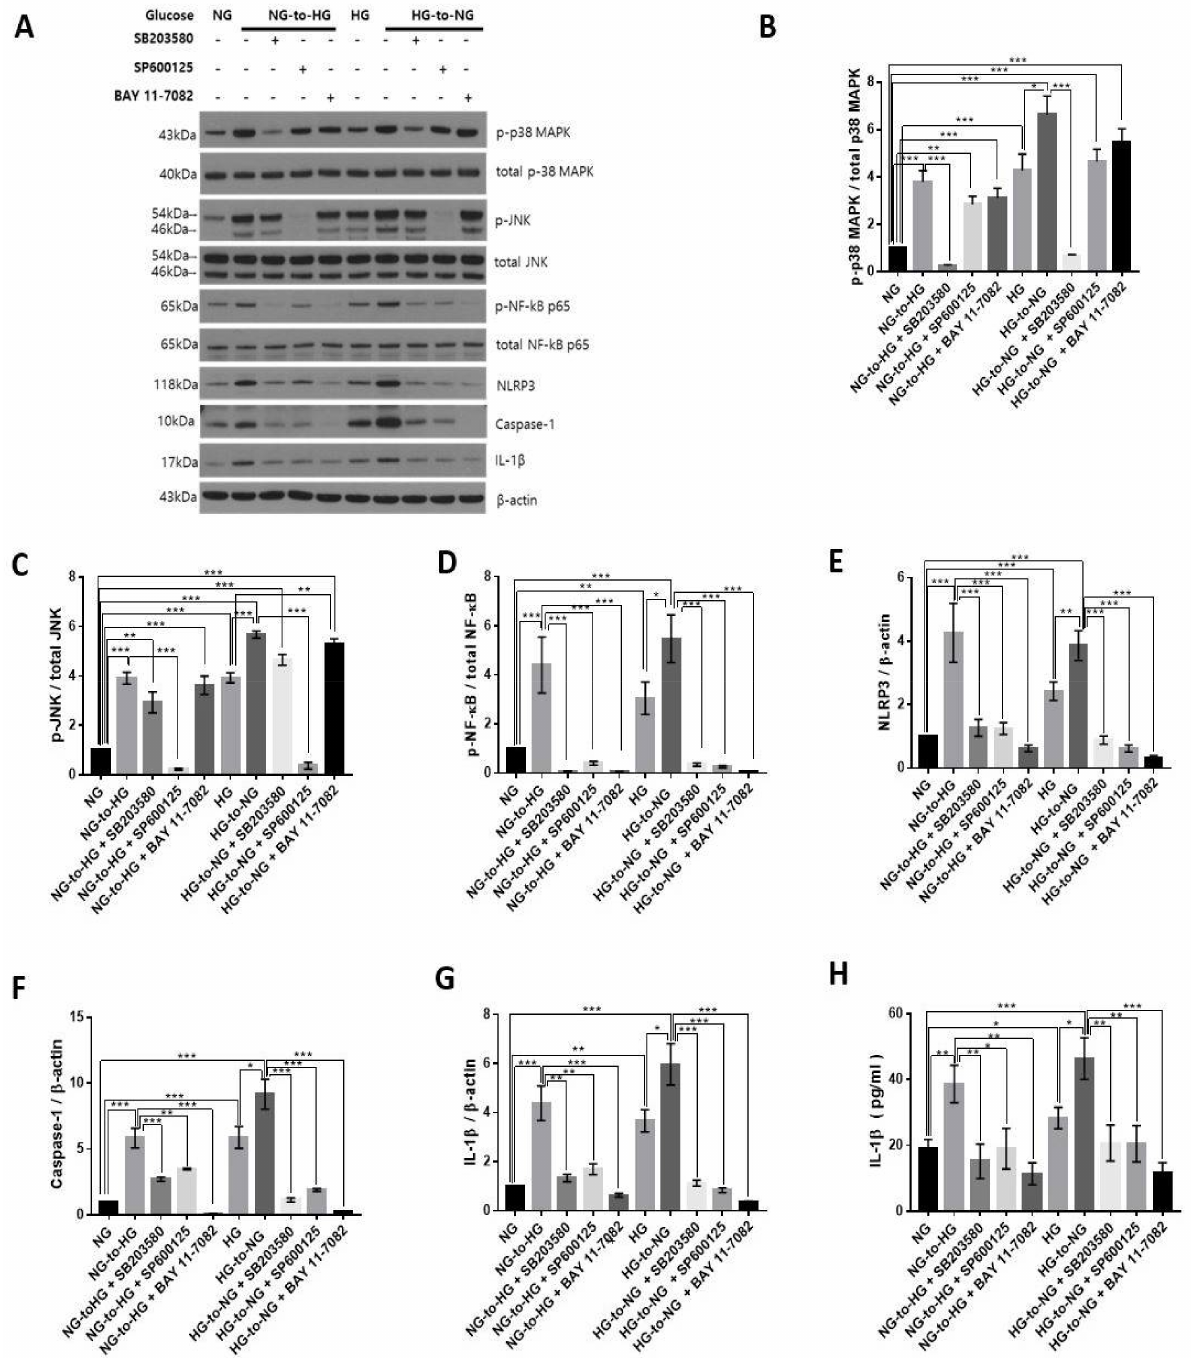
Figure 5. Acute glucose shift-induced activation of the NLRP3 inflammasome is p38 MAPK, JNK /NF- κ B-dependent. THP-1 cells were pretreated with SB203580 (10 µ M), SP600125 (20 µ M), and Bay 11-7082 (10 µ M) for 2 h and then exposed to an acute glucose shift for 24 h. ( A ) Western blotting was performed to detect the expression of p-p38 MAPK, p-JNK, p-NF- κ B, NLRP3, caspase-1, and IL-1 β . ( B – G ) The expression levels of p-p38 MAPK, p-JNK, p-NF- κ B, NLRP3, caspase-1, and IL-1 β were quantified using ImageJ. ( H ) The level of IL-1 β in the culture supernatant was determined by ELISA. Data are presented as the mean ± SEM from at least three independent experiments. * p < 0.05, ** p < 0.01, *** p <